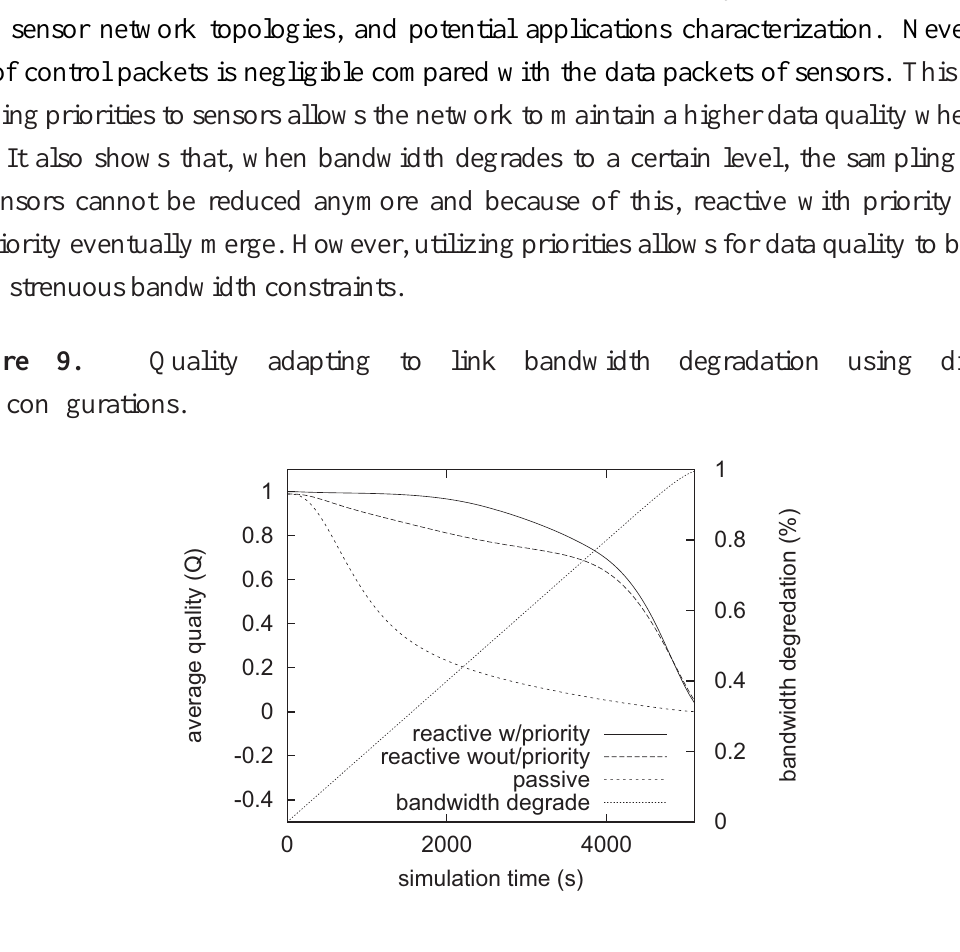
Table 1. Key parameters used in NS